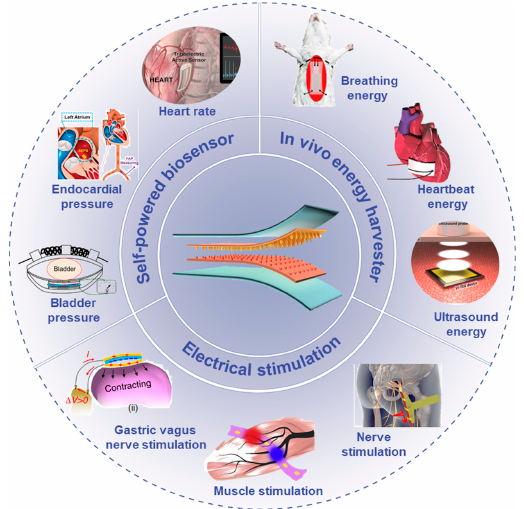
Figure 1. Overview of the implantable biomedical devices based on triboelectric nanogenerators (TENGs) incorporating self-powered biosensors, in vivo energy harvesters, and electrical stimula- tion. Reprinted with permission from Ref. [102]. Copyright 2016 American Chemical Society; Re- printed with permission from Ref. [103]. Copyright 2018 John Wiley & Sons; Reprinted with per- mission from Ref. [104]. Copyright 2018 American Chemical Society; Reprinted with permission from Ref. [105]. Copyright 2018 American Chemical Society; reprinted with permission from Ref. [3]. Copyright 2016 American Chemical Society; reprinted with permission from Ref. [106]. Copy- right 2019 American Association for the Advancement of Science; reprinted with permission from